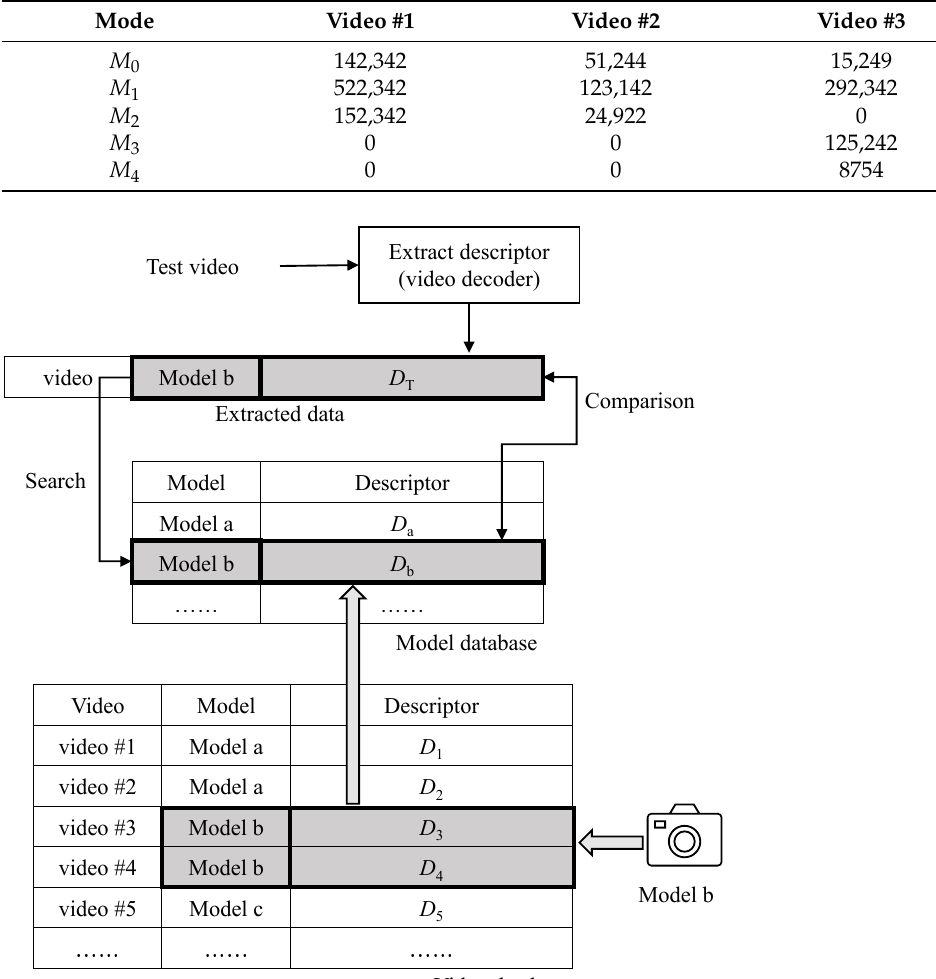
Figure 3. Proposed detection